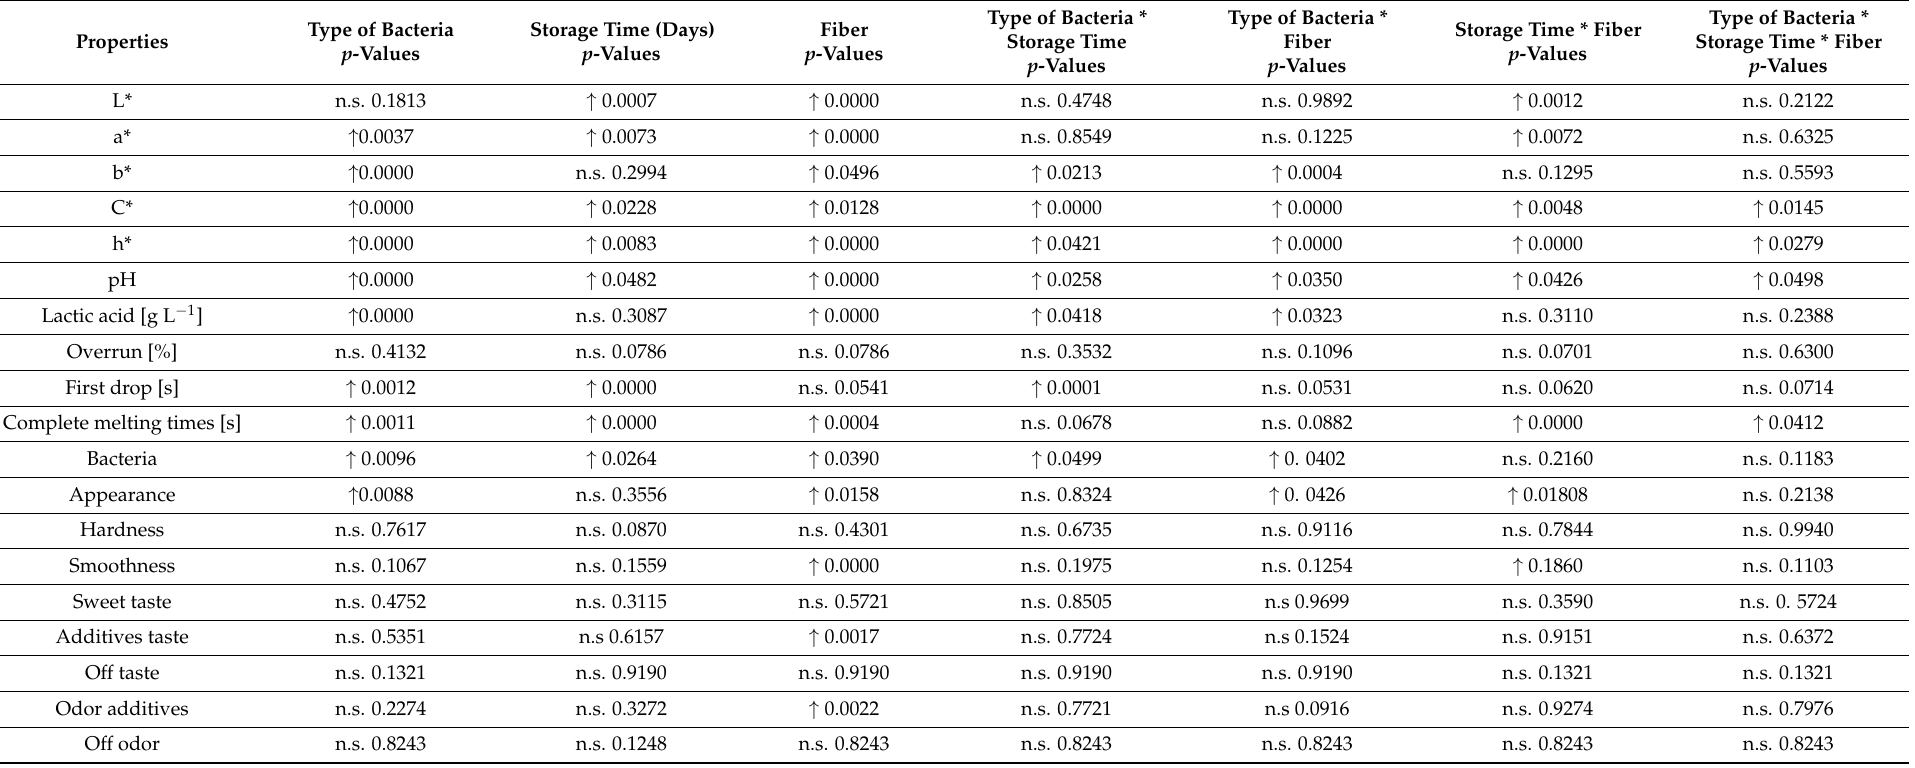
Table 3. Analysis of variance (ANOVA) p -values on the effects of storage time and type of bacteria and fiber on color, pH, lactic acid, overrun, bacteria appearance, hardness, smoothness, sweet taste, additives taste, off taste, odor additives, and off odor of ice